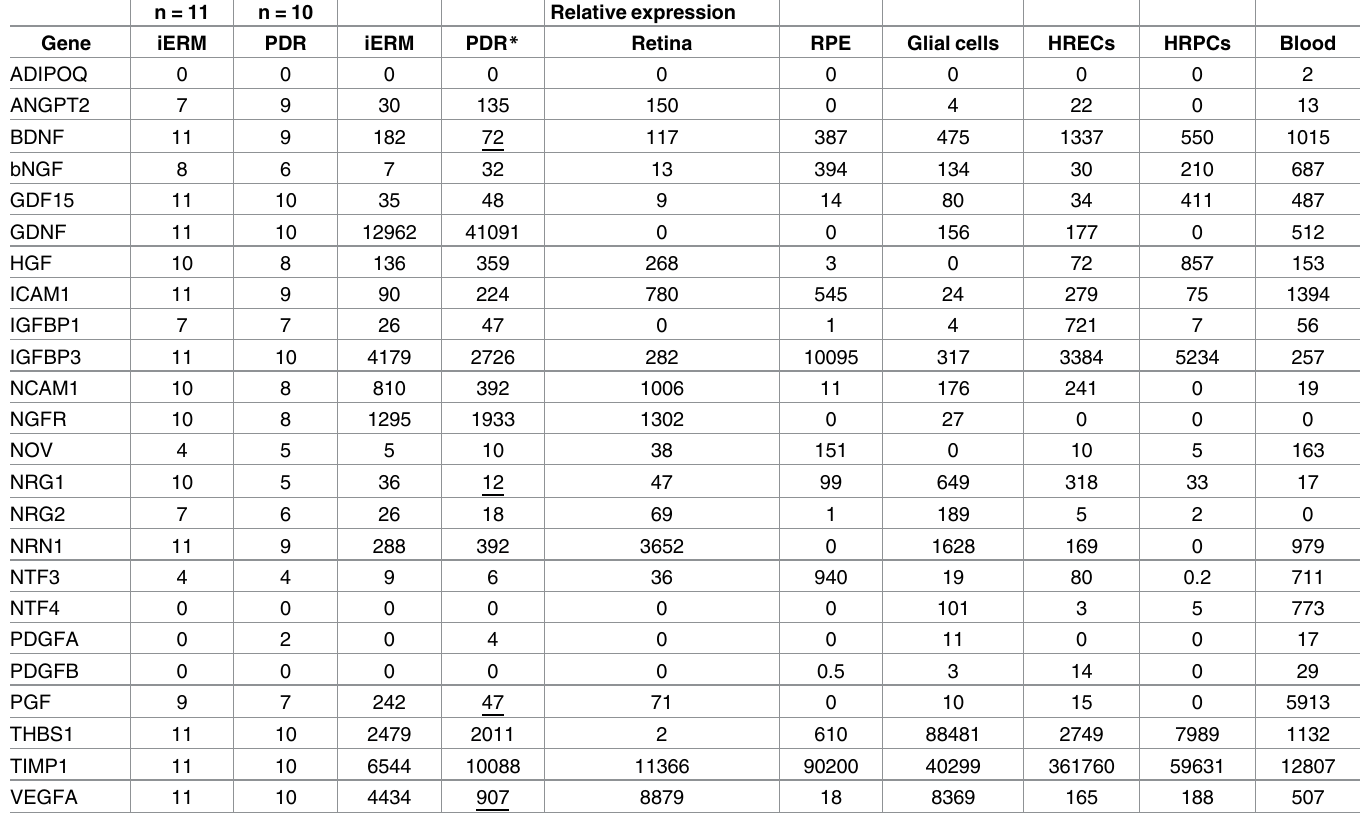
(RPE), human retinal endothelial cells (HRECs), human retinal pericytes (HRPCs) and human glial cells (Table 4). In total 11 idiopathic ERMs, and 10 PDR membranes were analyzed. In accordance with protein concentrations found in the vitreous of PDR patients, 5 genes were found to be consistently expressed in all PDR membranes ( GDF15 , IGFBP3 , THBS1 , TIMP1 and VEGFA ). In addition, BDNF and GDNF were found to be expressed in all idio- pathic and 9 of the 10 PDR membranes (Table 4), even though protein concentrations of these respective proteins in the vitreous were below the LOD (Table 3).